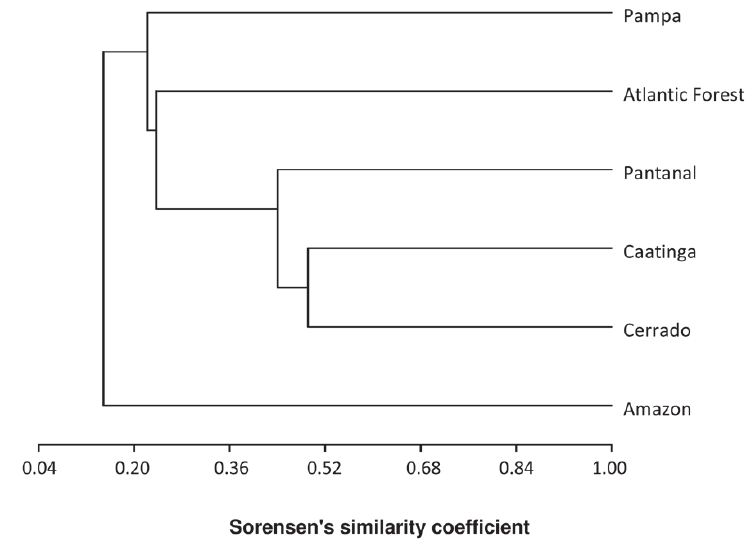
Figure 3 - Dendrogram of similarity of amphibian species recorded among the Brazilian